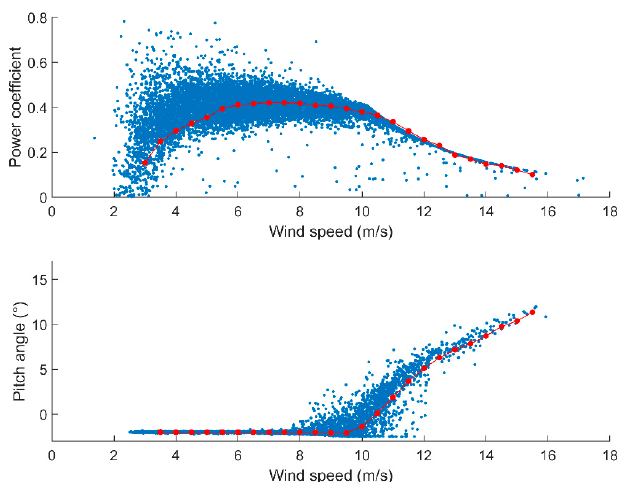
Figure 5. Power coefficient and blade pitch angle as a function of the wind speed for the study turbines from SCADA data. The 10 minutes average values are shown in blue dots and binned averages are red.